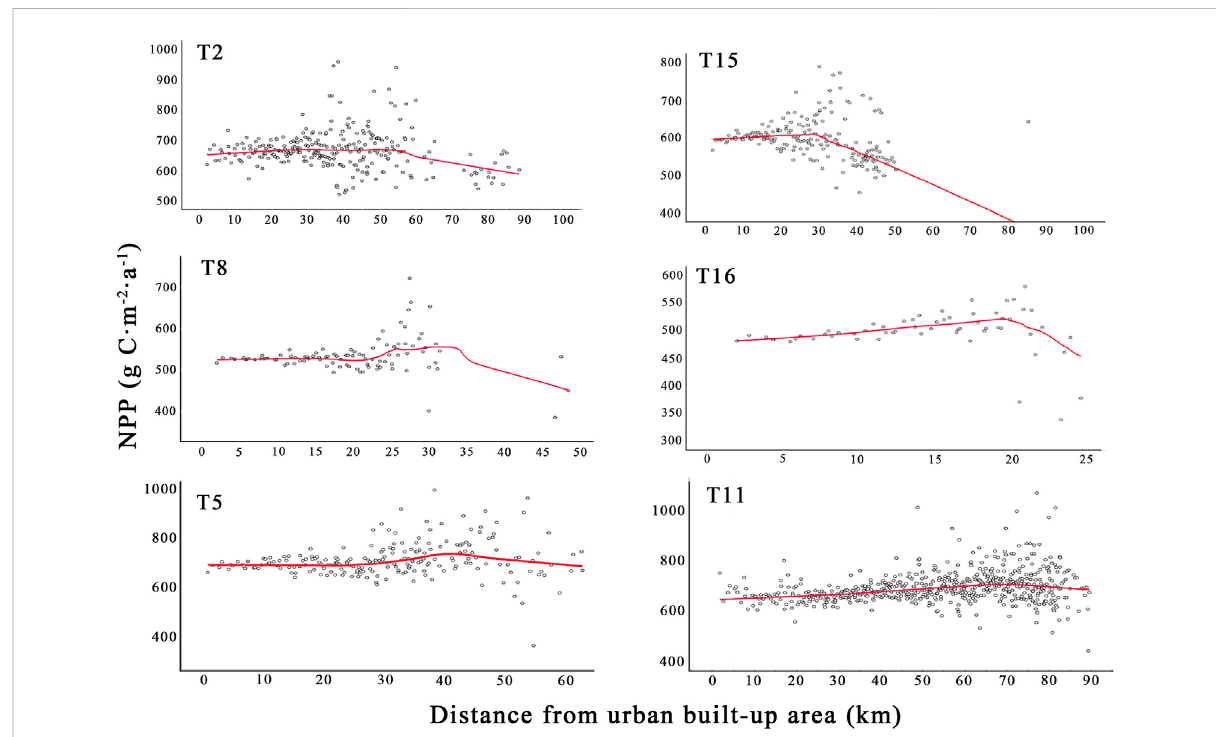
FIGURE 7 Unimodal curve relationships between NPP supply capacity and distance from built-up area.